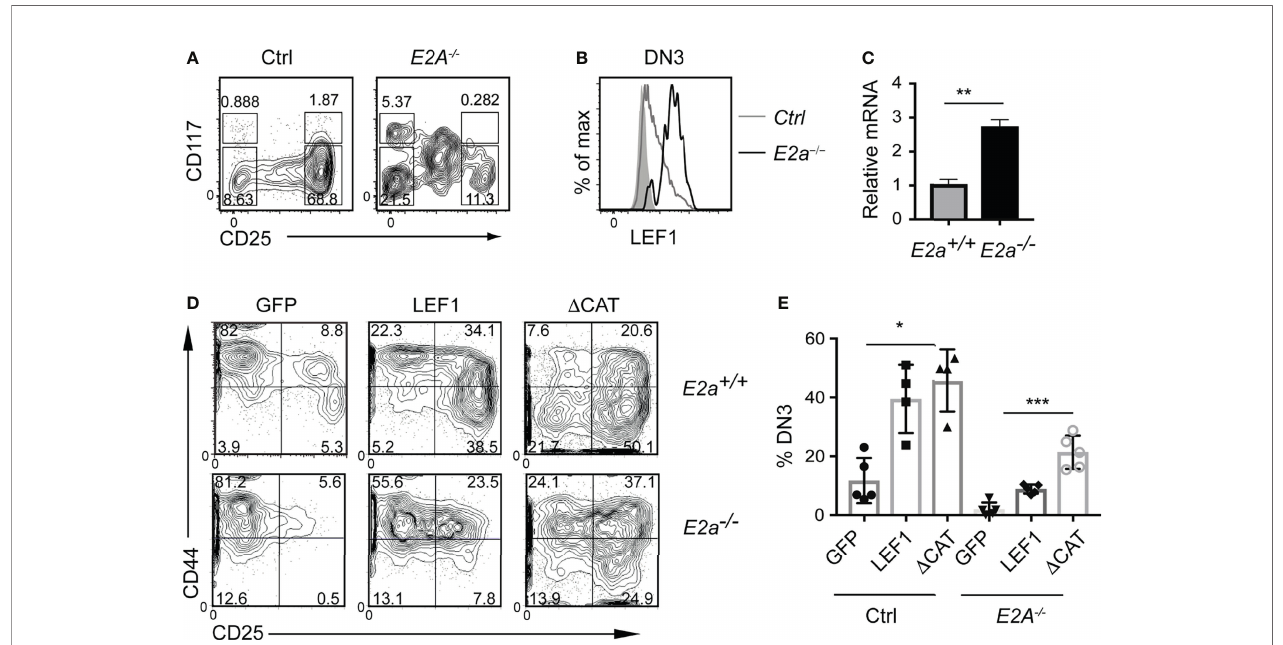
FIGURE 2 | LEF1 is highly expressed in E2a -/- DN3 cells and promotes their development from MPPs. (A) Flow cytometry showing CD117 and CD25 on Lineage - (CD4, CD8, CD11b, Ter119) thymocytes from Ctrl (left) and E2a -/- (right) mice at 5 weeks of age. (B) LEF1 expression in DN3 thymocytes from Ctrl (grey) and E2a -/- (black) mice. (C) Summary of Lef1 mRNA relative to Hprt mRNA in Ctrl (grey) and E2a -/- (black) DN3 thymocytes. Data are representative of mice at 5-6 weeks of age. **p < 0.01 Student ’ s t-test. (D) Flow cytometry of MPPs isolated from Ctrl (top) or E2a -/- (bottom) embryos (16 days p.c.) cultured in vitro for 10 days after retroviral transduction with MigR1 (GFP), MigR1-LEF1 or MigR1-LEF1 D CAT. Data are gated on GFP + cells. (E) Summary of the %DN3 cells in the Lineage - population of MPPs cultured in vitro as in (D) from the indicated strains. Data are representative of (A, B) n = 3, (C) n = 2, (D, E) n = 4-6 experiments. *p < 0.05, **p < 0.01 and ***p < 0.005